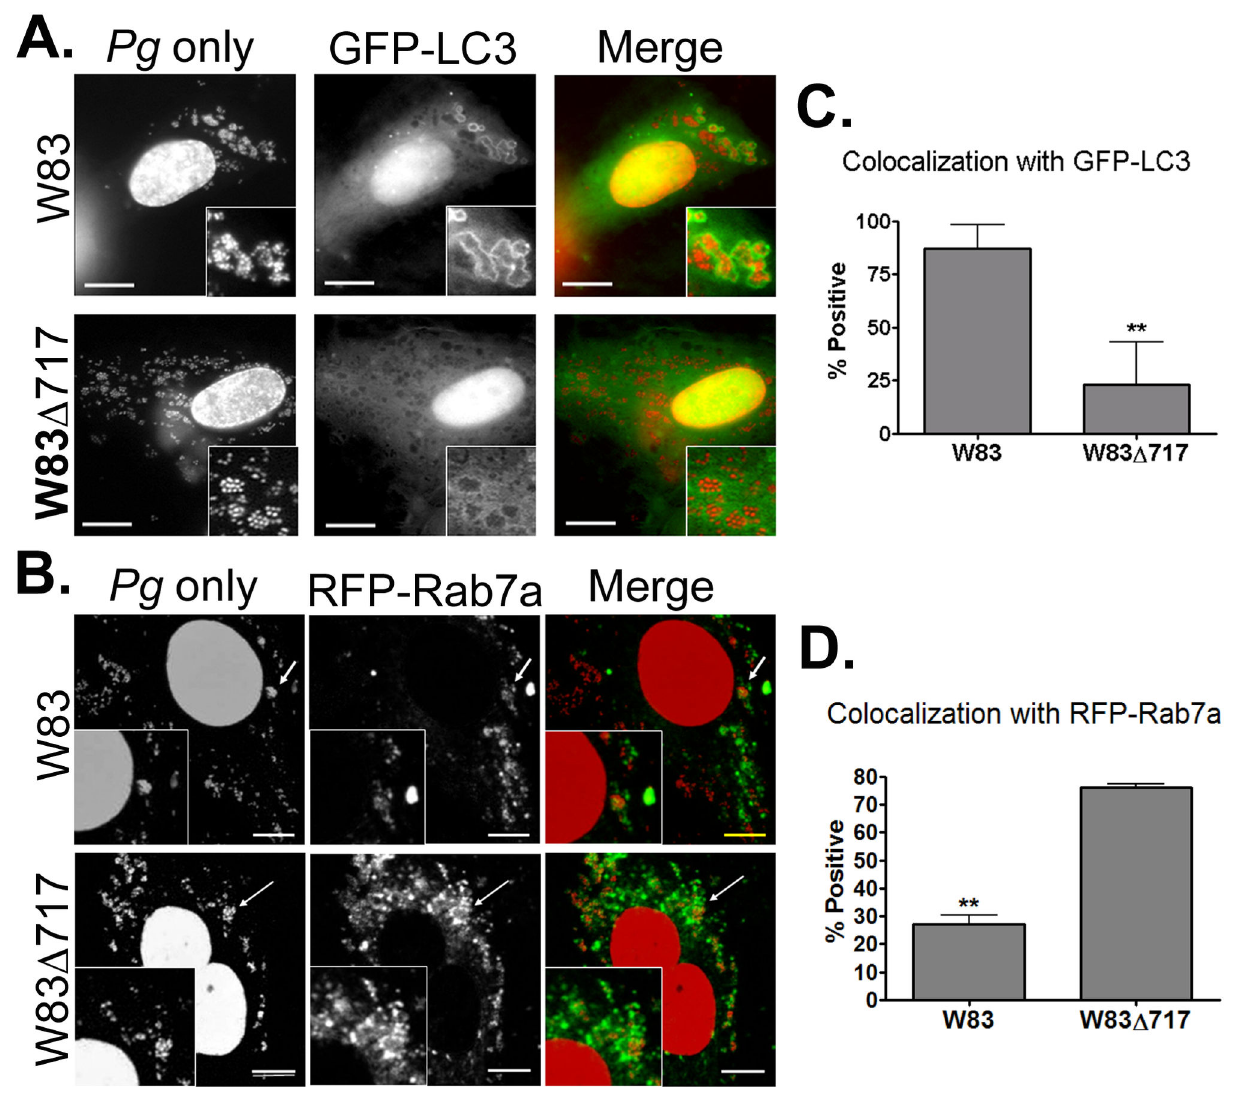
Figure 2. Intracellular trafficking of P. gingivalis in HCAEC. A) Colocalization of W83 and W83Δ717 (red) with GFP-LC3 (green) at 6 hours post-inoculation. B) Colocalization of W83 and W83Δ717 (red) with RFP-Rab7a (pseudocolored green) at 6